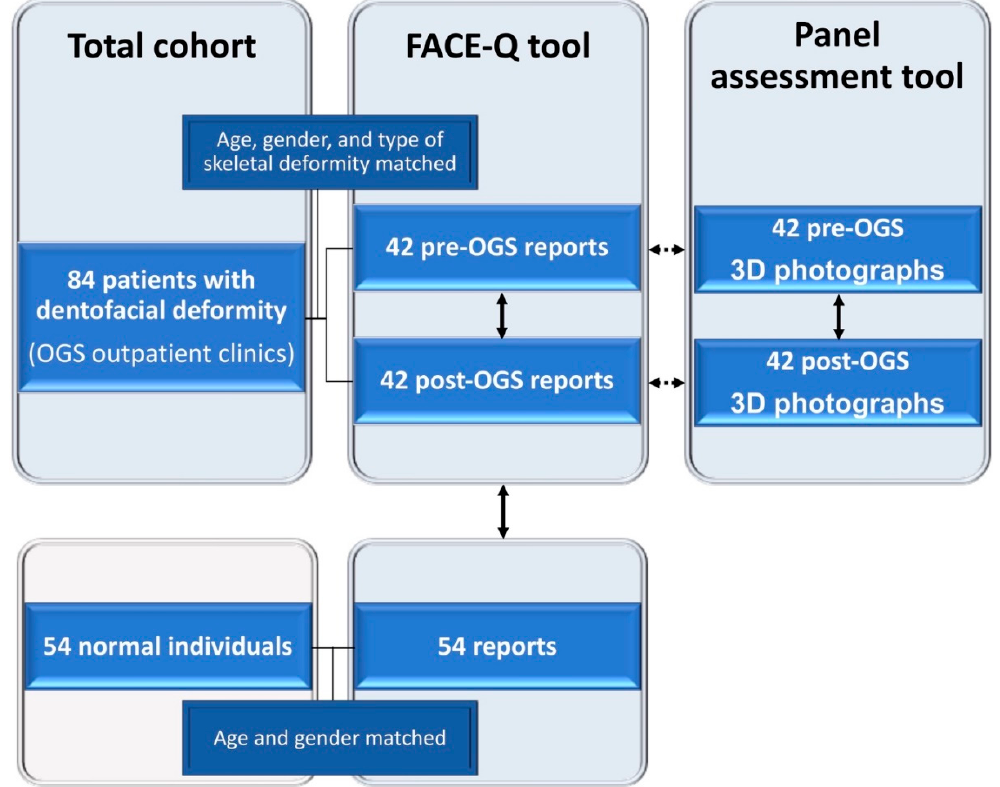
Figure 1. A flowchart for data collection in the comparative cross-sectional study using FACE-Q (pre- and post-orthognathic surgery (OGS) patient and normal individual reports) and panel assessment (clinicians’ and observers’ perceptions of patients’ three-dimensional (3D) facial photographs) tools. Solid line arrows and dotted line arrows indicate comparison and correlation analyses, respectively.